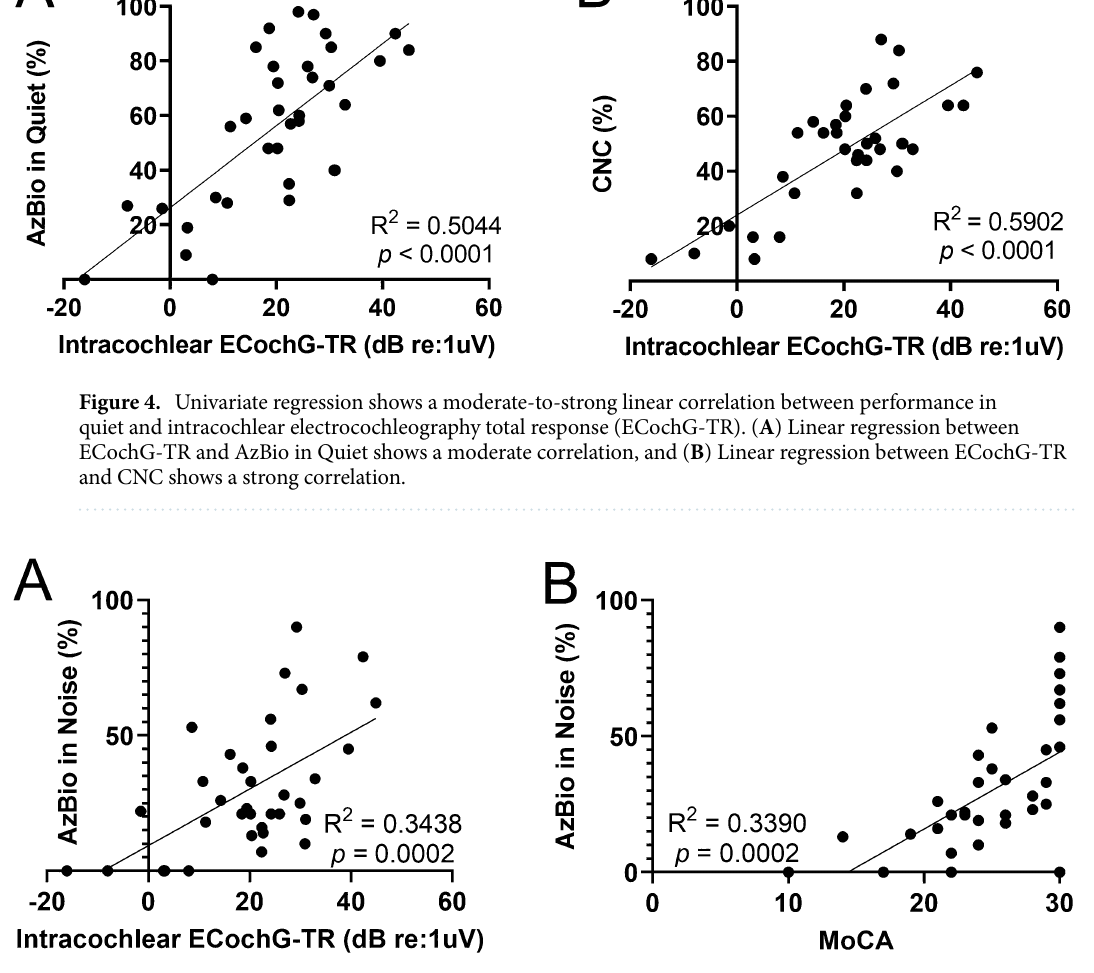
Figure 5. Independent univariate linear regression for predictors of performance in noise: ( A ) Electrocochleography total response (ECochG-TR) is a moderate predictor for performance in noise (AzBio + 10 dB SNR), ( B ) Montreal Cognitive Assessment score (MoCA) demonstrates a moderate linear correlation with performance in